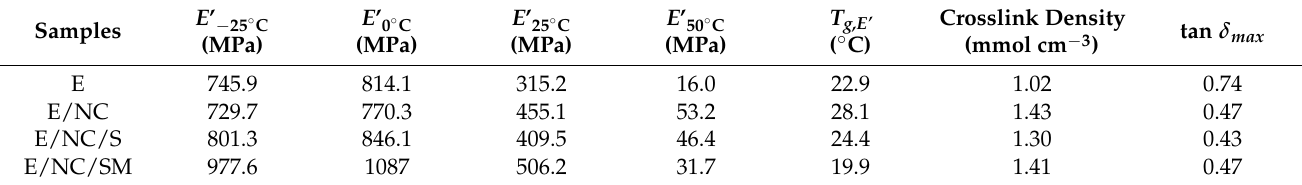
Table 2. Dynamic mechanical data for epoxy matrix and nanocomposites containing NCs.